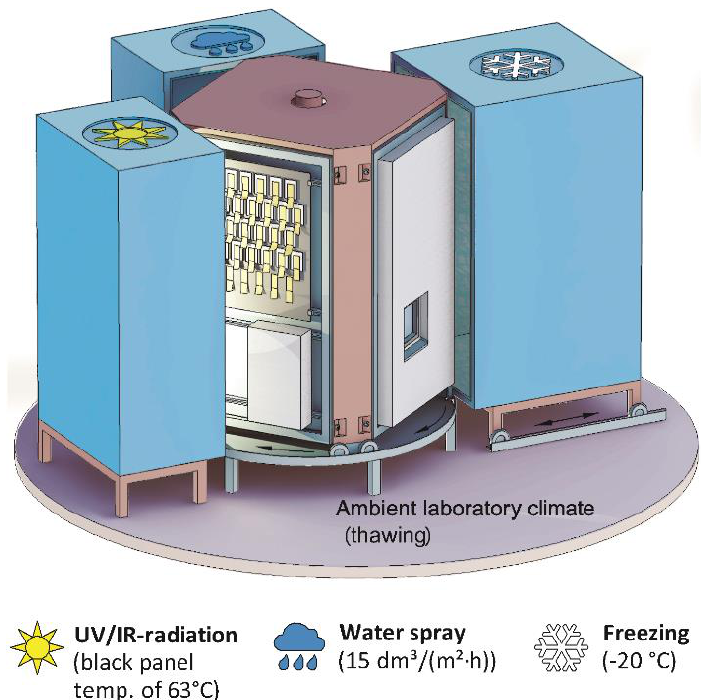
Figure 4. SINTEF ’ s climate simulator with four climate zones. The mid-section is rotating clockwise. The ageing factors vary and are dependent on the exposed materials. In practice, the effect of natural ageing on surface treatments is dependent not only on the product that is being used but also on the local climate as well as on both the condition of the substructure and the quality of workmanship. The purpose of the accelerated climatic ageing is to compare the ageing properties of different materials, systems, and techniques. Accordingly, the testing does not provide an accurate estimate of service life expressed in terms of number of